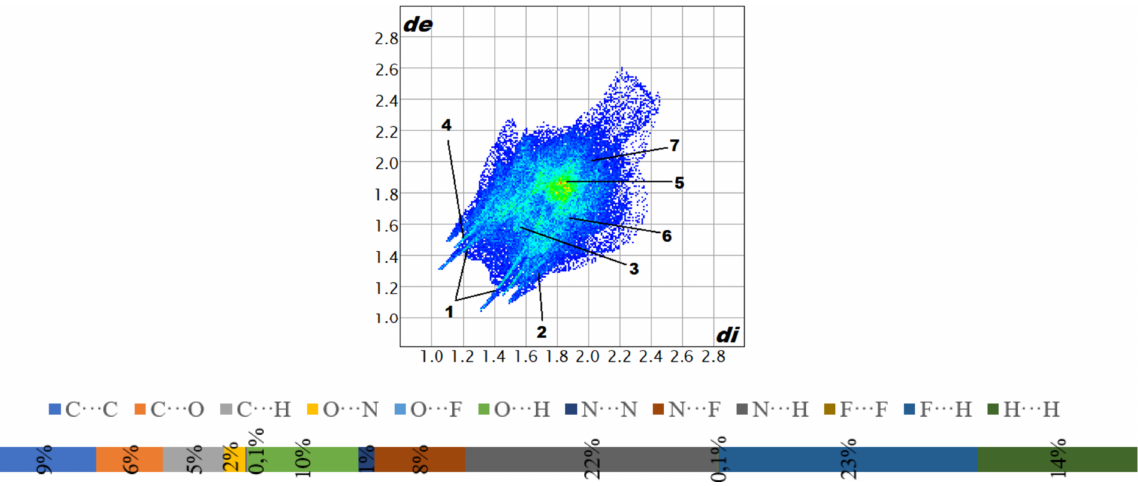
Figure 4. Top: 2D-fingerprint plot of 4 . Close contacts are labeled as 1: F ··· H (23%), 2: N ··· H (22%), 3: H ··· H (14%), 4: O ··· H (10%), 5: C ··· C (9%), 6: N ··· F (8%), 7: C ··· O (6%). Bottom: Relative contribution (%) of intermolecular contacts to the Hirshfeld surface area of 4